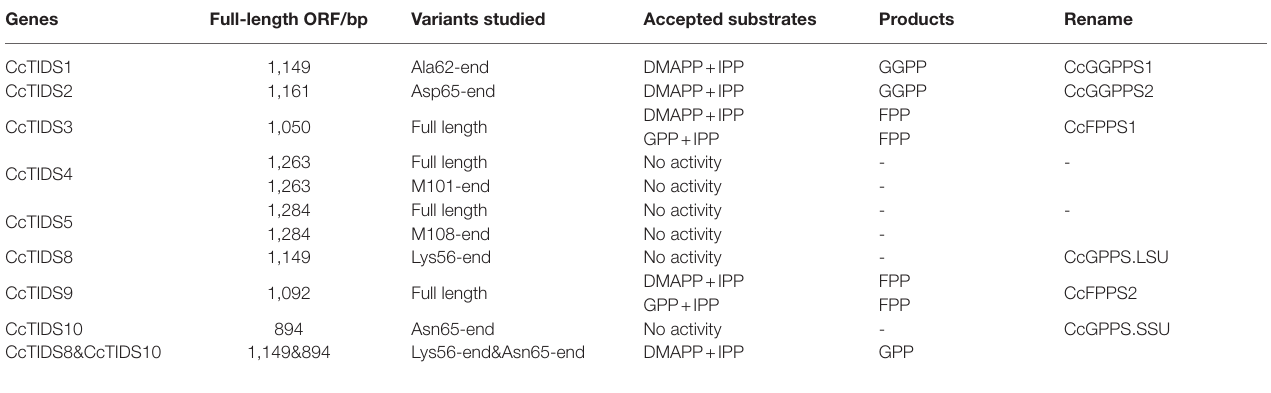
TABLE 2 | Functionally characterized enzymes in this